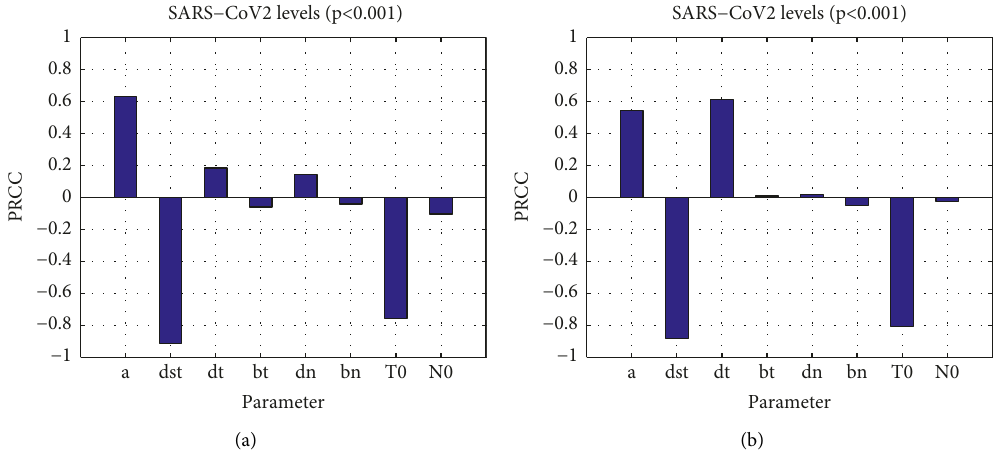
Figure 10: Sensitivity analysis for 4 (a) and 23 (b) days postonset of symptoms.